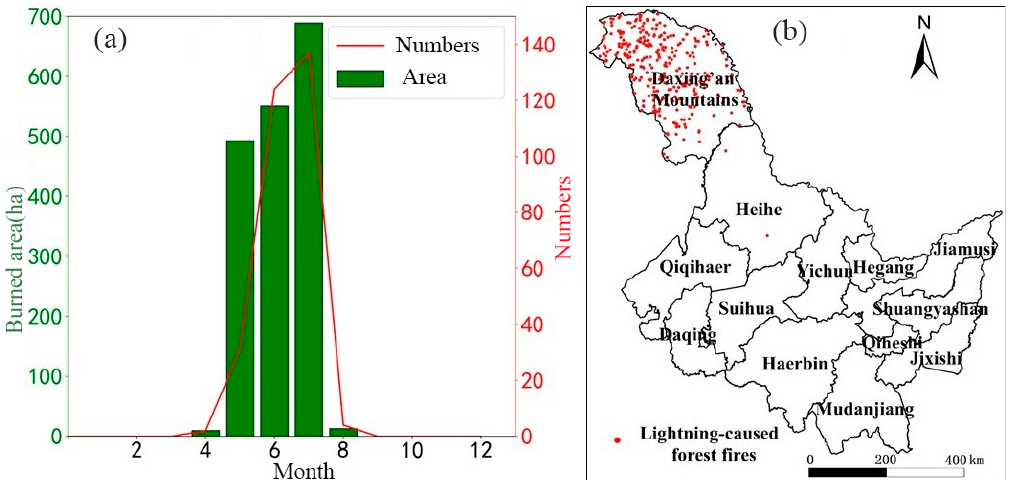
Figure 8. Monthly variation ( a ) and spatial distribution ( b ) of lightning-caused forest fires in the jurisdictions of Heilongjiang Province, 2013–2020.